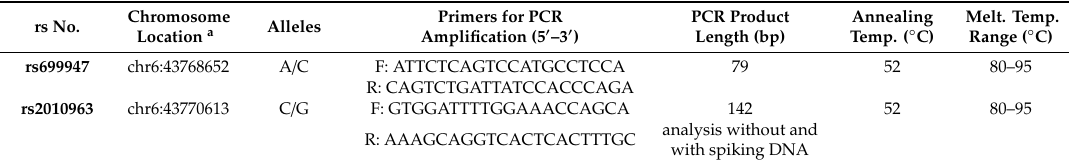
Table 1. Primers and high-resolution melting curve analysis (HRM) conditions for genotyping of vascular endothelial growth factor ( VEGF) gene